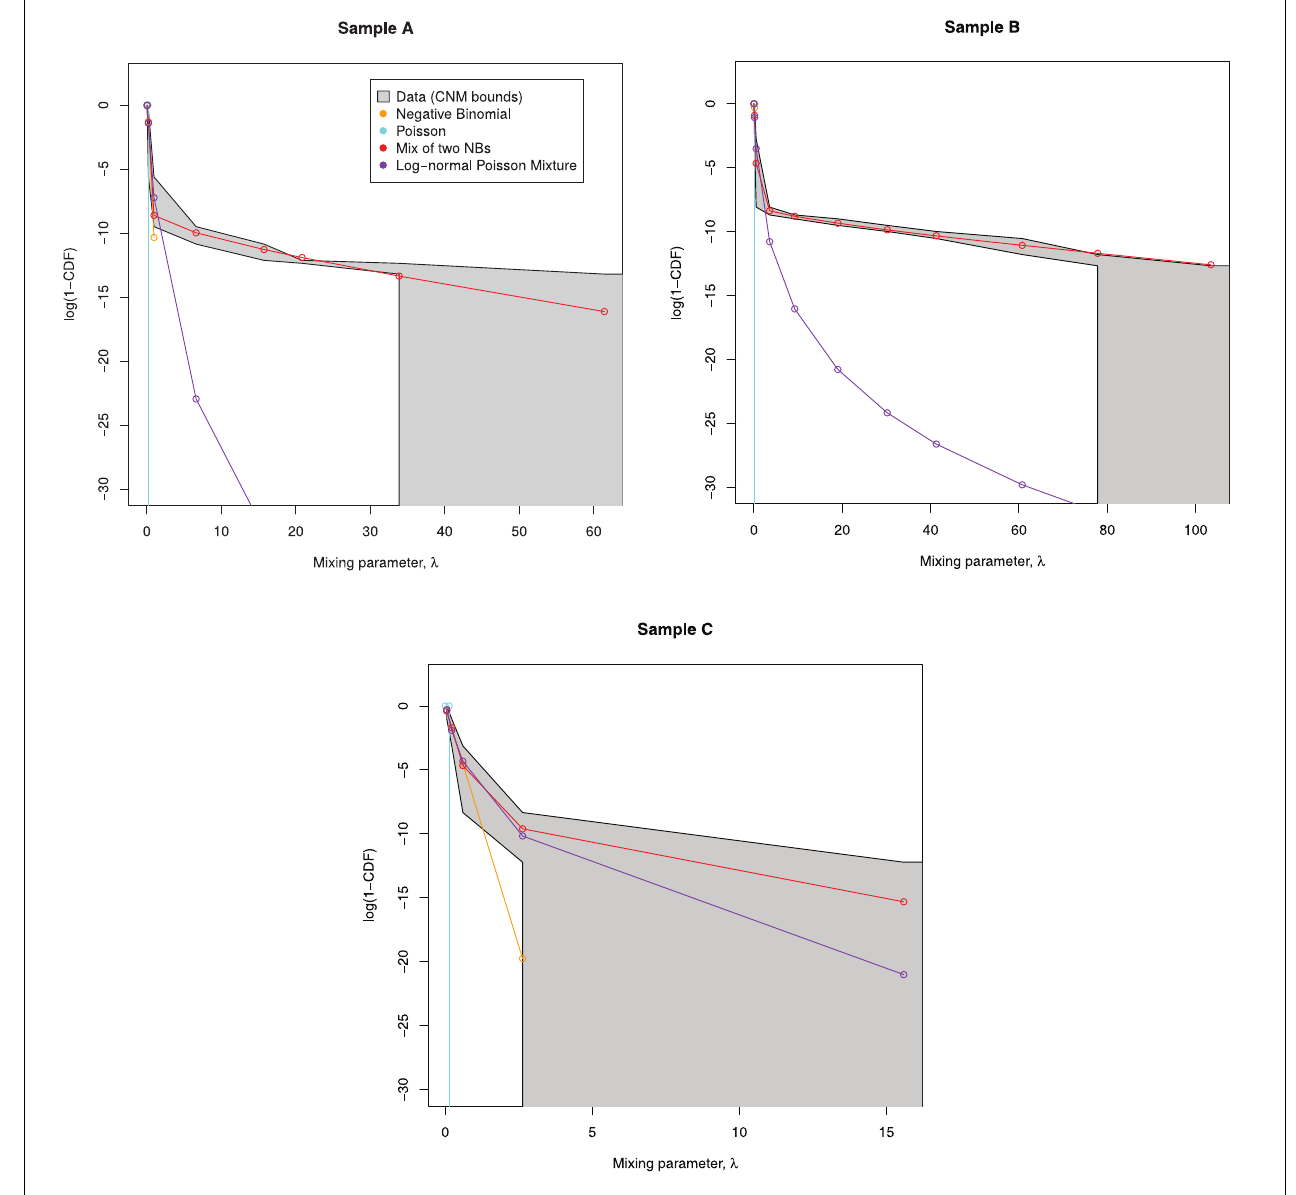
FIGURE 6 | Predicted mixing distributions, as per Figure 3, for each sample with the NB-NB mixture added. (Sample D is omitted since CNM did not recover its distribution.) The NB-NB mixture is the only model whose mixing distribution consistently fits between the CNM